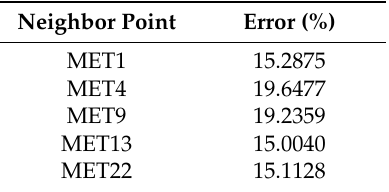
Table 3. Cross validation error for irradiance of five METs.